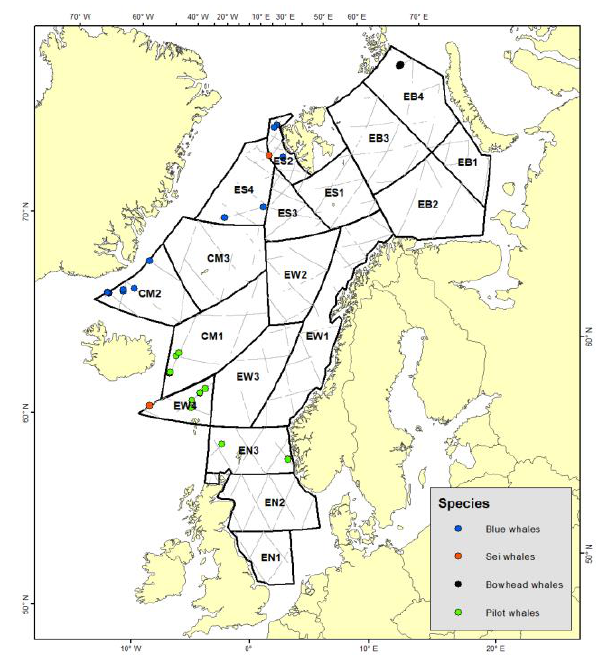
Figure 13 Distribution of blue whales, sei whales, bowhead whales and pilot whales sighted during the 2014 – 2018 sighting surveys. The blue areas represent ice coverage.